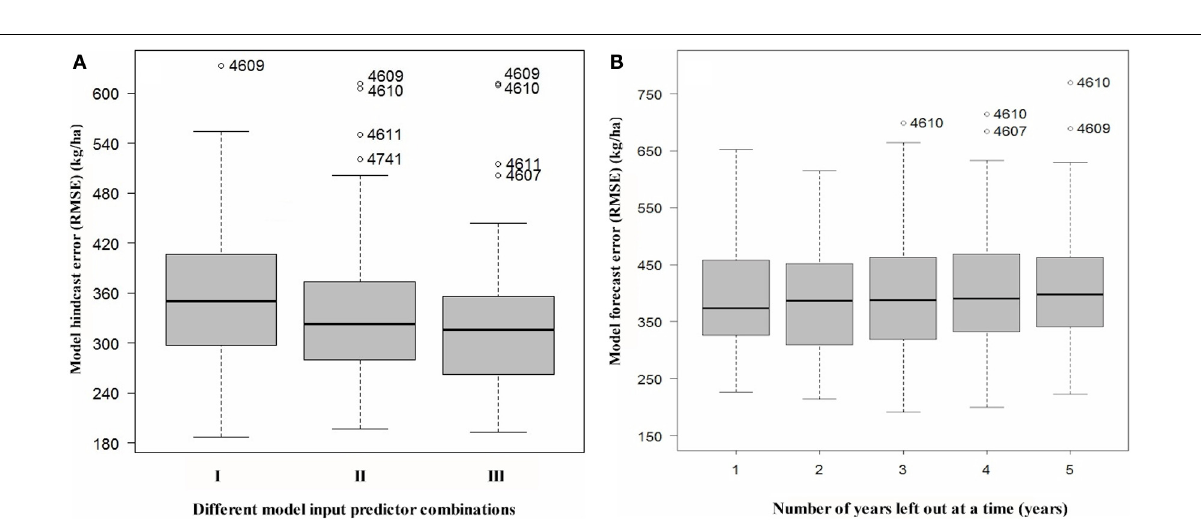
LOOCV procedure that considers all possible combinations of missing data (i.e., years) in the historical input data, also identifies CAR 4609 as an outlier. (B) Variation in model forecast error (i.e., skill) in terms of “degeneracy” in the input data, simulated by increasing the number of years at a time that were left out in the LOOCV cross-validation procedure. Results correspond to a total of 1000 MCMC runs. CAR 4606 was excluded as it had only 7 years of missing